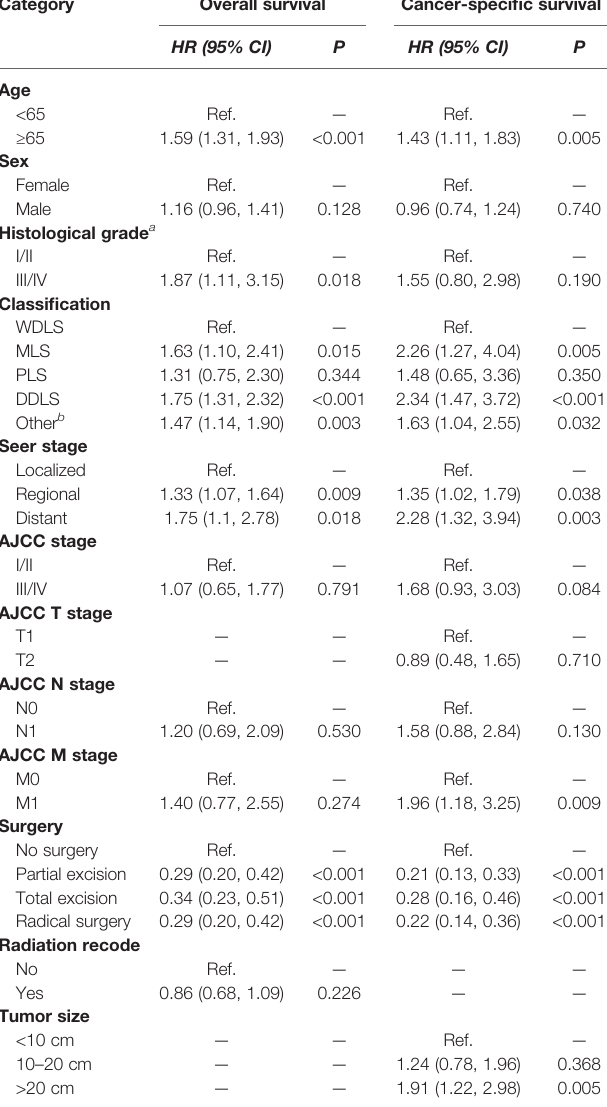
TABLE 3 | Multivariate analysis for overall survival and cancer-speci fi c survival in the training cohort. Category Overall survival Cancer-speci fi c